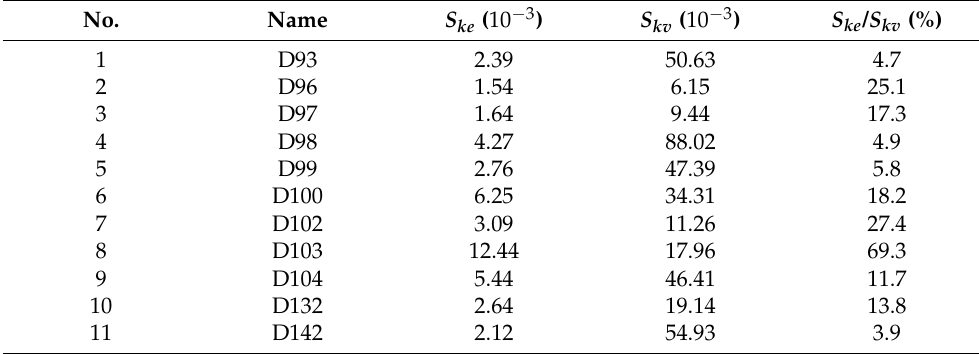
Table 2. Comparison between values of elastic and inelastic skeletal storativity. No.